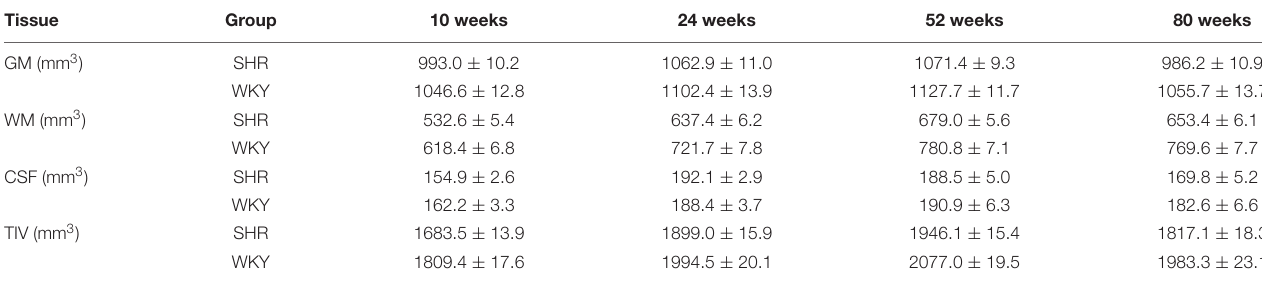
FIGURE 1 | Comparisons of brain volume (A–D) and volume index (E–G) changes in SHRs and WKY rats at 10, 24, 52, and 80 weeks old. + indicates significant interactions of group and age. # Indicates a significant volume difference between SHRs and age-matched WKY rats, and * indicates a significant trend determined by paired t -tests in each group. Positive correlation between TIV and body weight in both groups (H) . TABLE 1 | Brain volume of the gray matter (GM), white matter (WM), cerebrospinal fluid (CSF), and total intracranial volume (TIV) in spontaneously hypertensive rats (SHRs) and Wistar-Kyoto (WKY) rats at 10, 24, 52, and 80 weeks old. Tissue Group 10